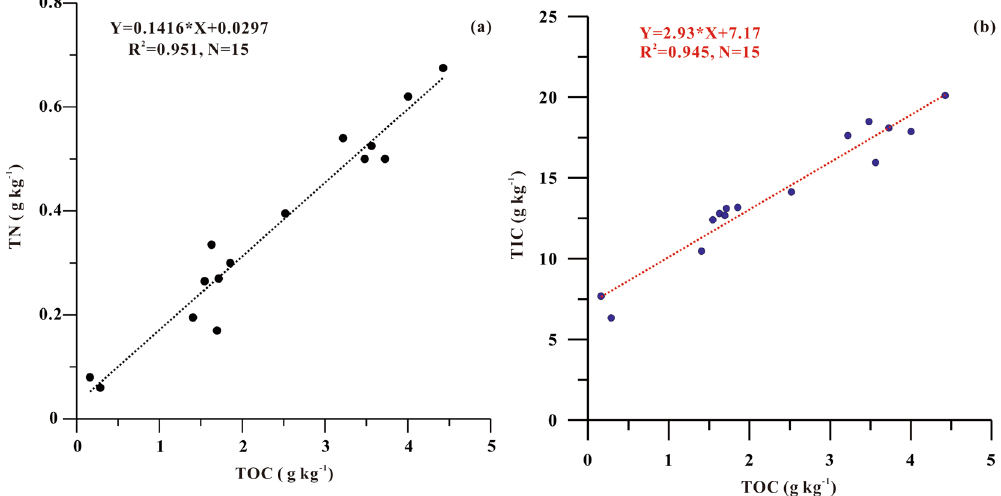
Figure 5. Relationship between (a) TOC and TN, (b) TOC and TIC in surface sediments of the Yellow River Estuary.